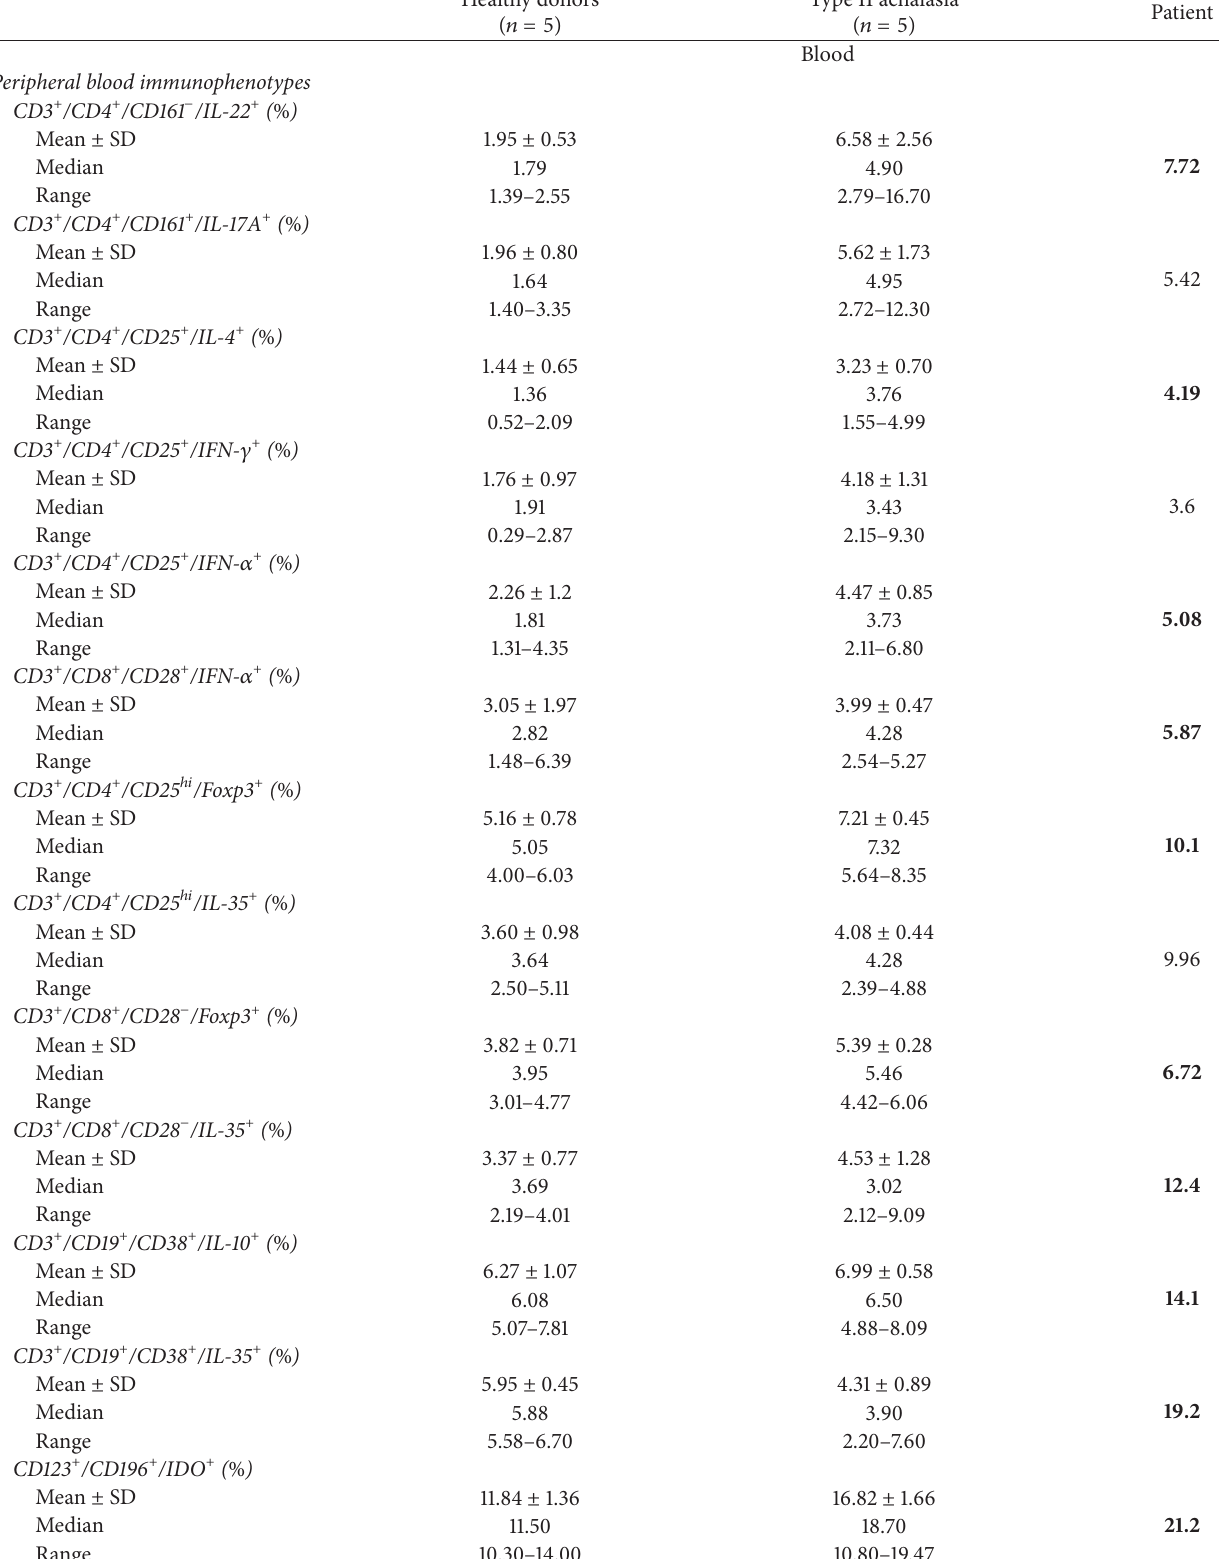
Table 1: Analysis of peripheral blood and tissue immunophenotypes in the present case compared to 5 achalasia patients and 5 control